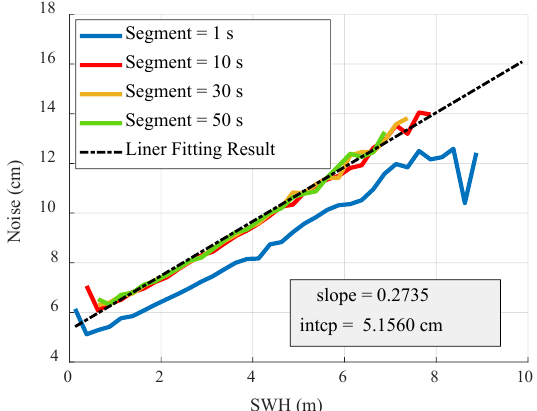
Figure 7. The median curves of different segment durations calculated using the differential method. The black dashed line represents the linear fitting result when the segment duration was 50 s.